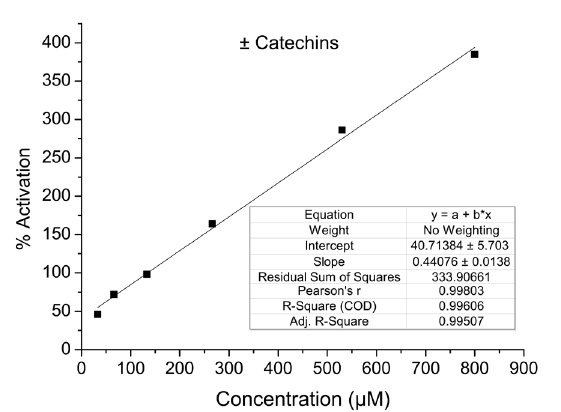
Figure 2. Dose-dependent activation effects on tyrosinase by ±catechins (catechin and epi